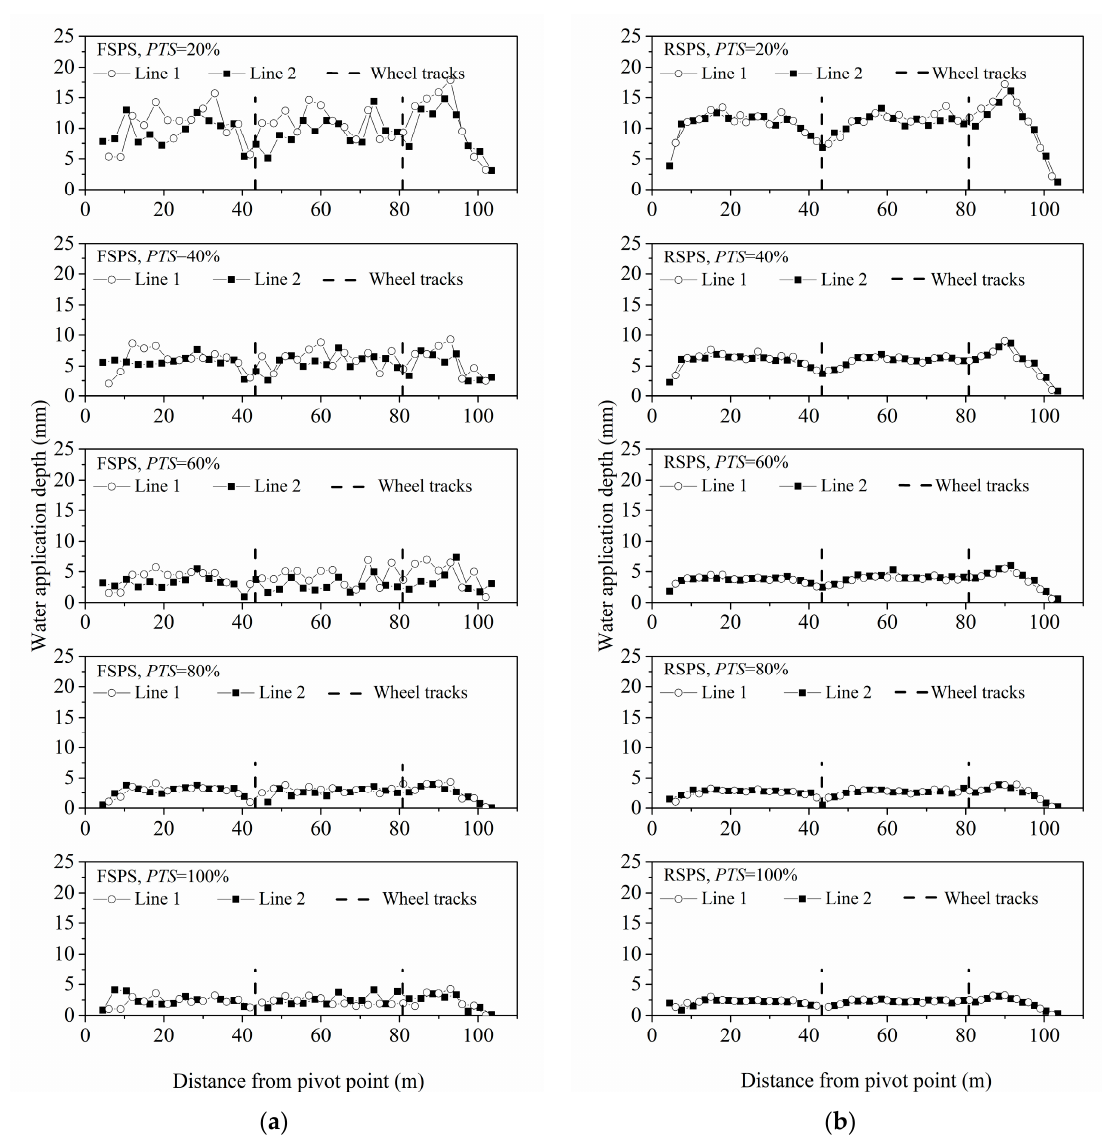
Figure 5. Water application depth versus distance from the pivot point for collector I: ( a ) FSPS, PTS = 20%–100%; ( b ) RSPS, PTS = 20%–100%. Table 3. Water application uniformities of the center pivot irrigation system with FSPS and RSPS for collector I at the five travel speeds.